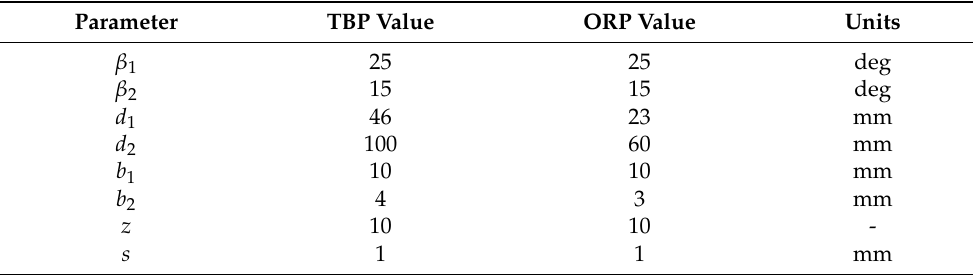
Figure 3. Impeller main geometric parameters. Table 1. Main dimensions of the test bench prototype (TBP) and an onboard robot prototype (ORP) impellers